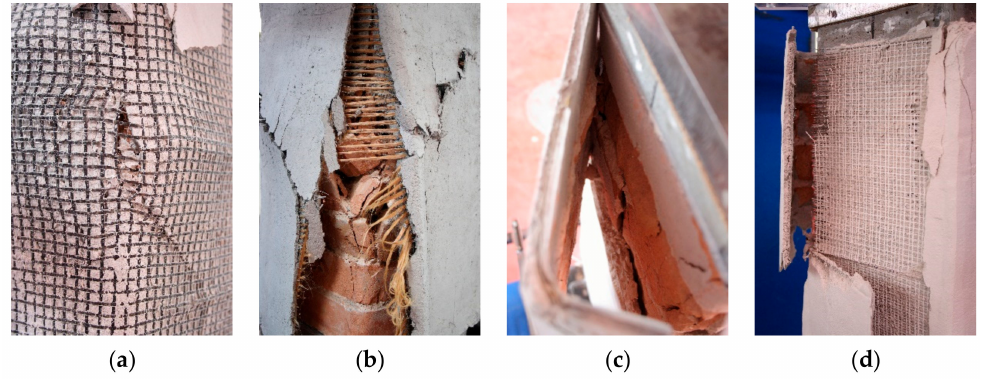
Figure 11. Details of the specimen’s failure: knife e ff ect in ( a ) C-B-1-0; ( b ) C-P-1-0 specimens; ( c ) detachment in the C-S-1-1 specimen; and ( d ) detachment and fiber rupture in the C-S-1-2